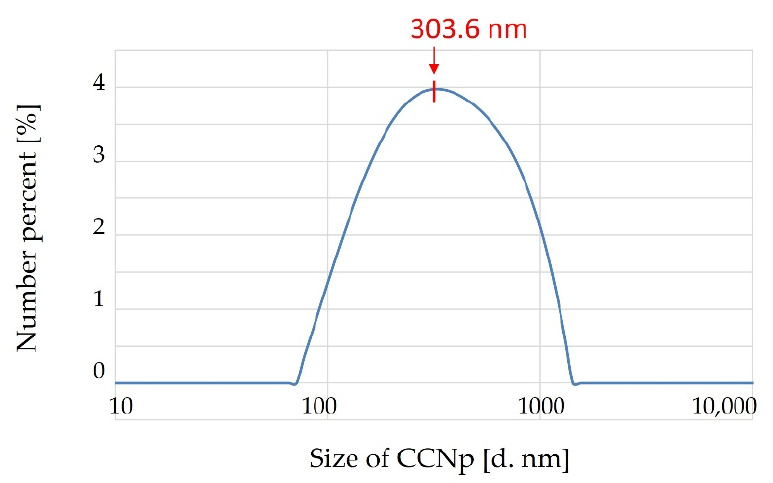
Figure 5. Distribution of CCNPs using DLS analysis.